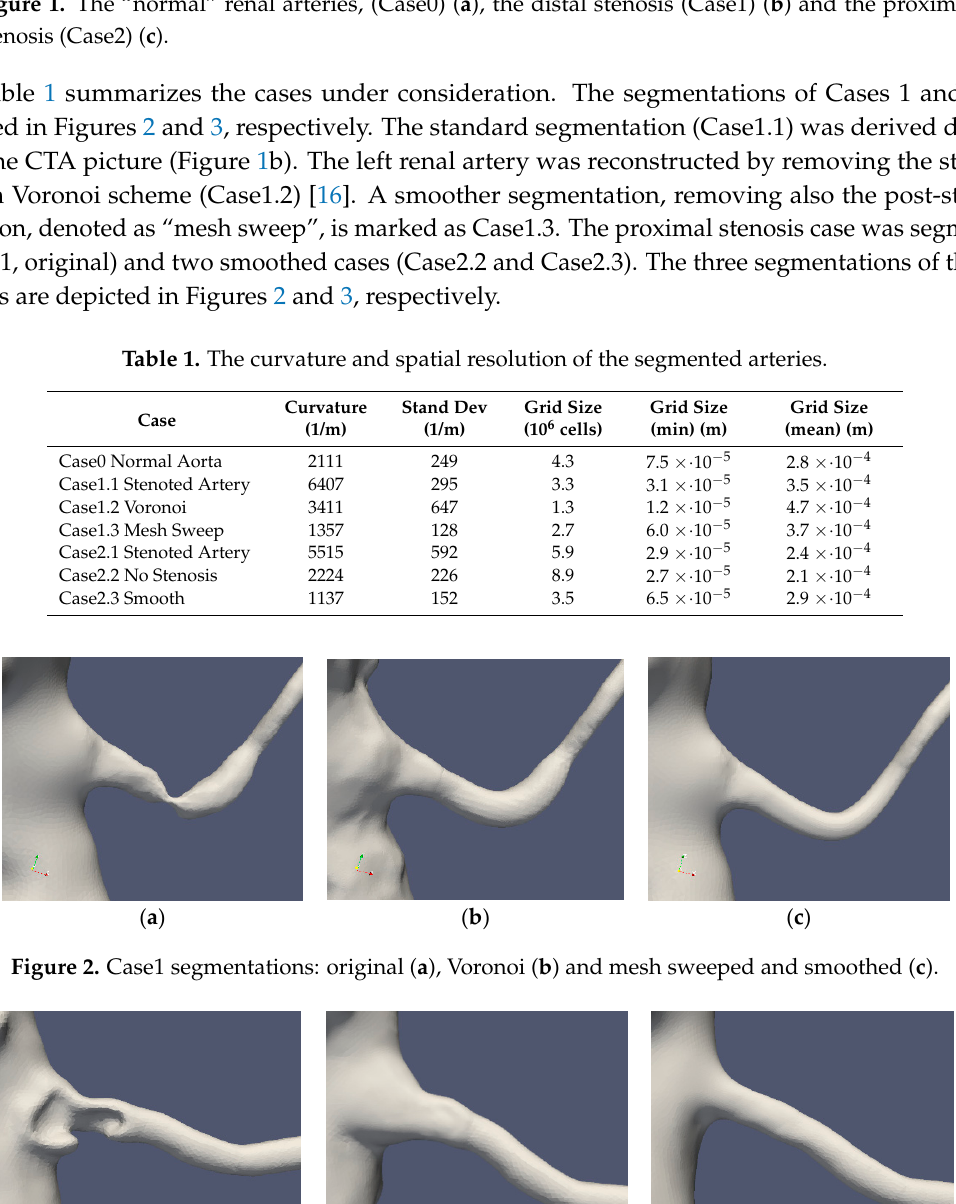
Figure 3. Case2 segmentations: original ( a ), reconstructed ( b ) and smoothed ( c ).